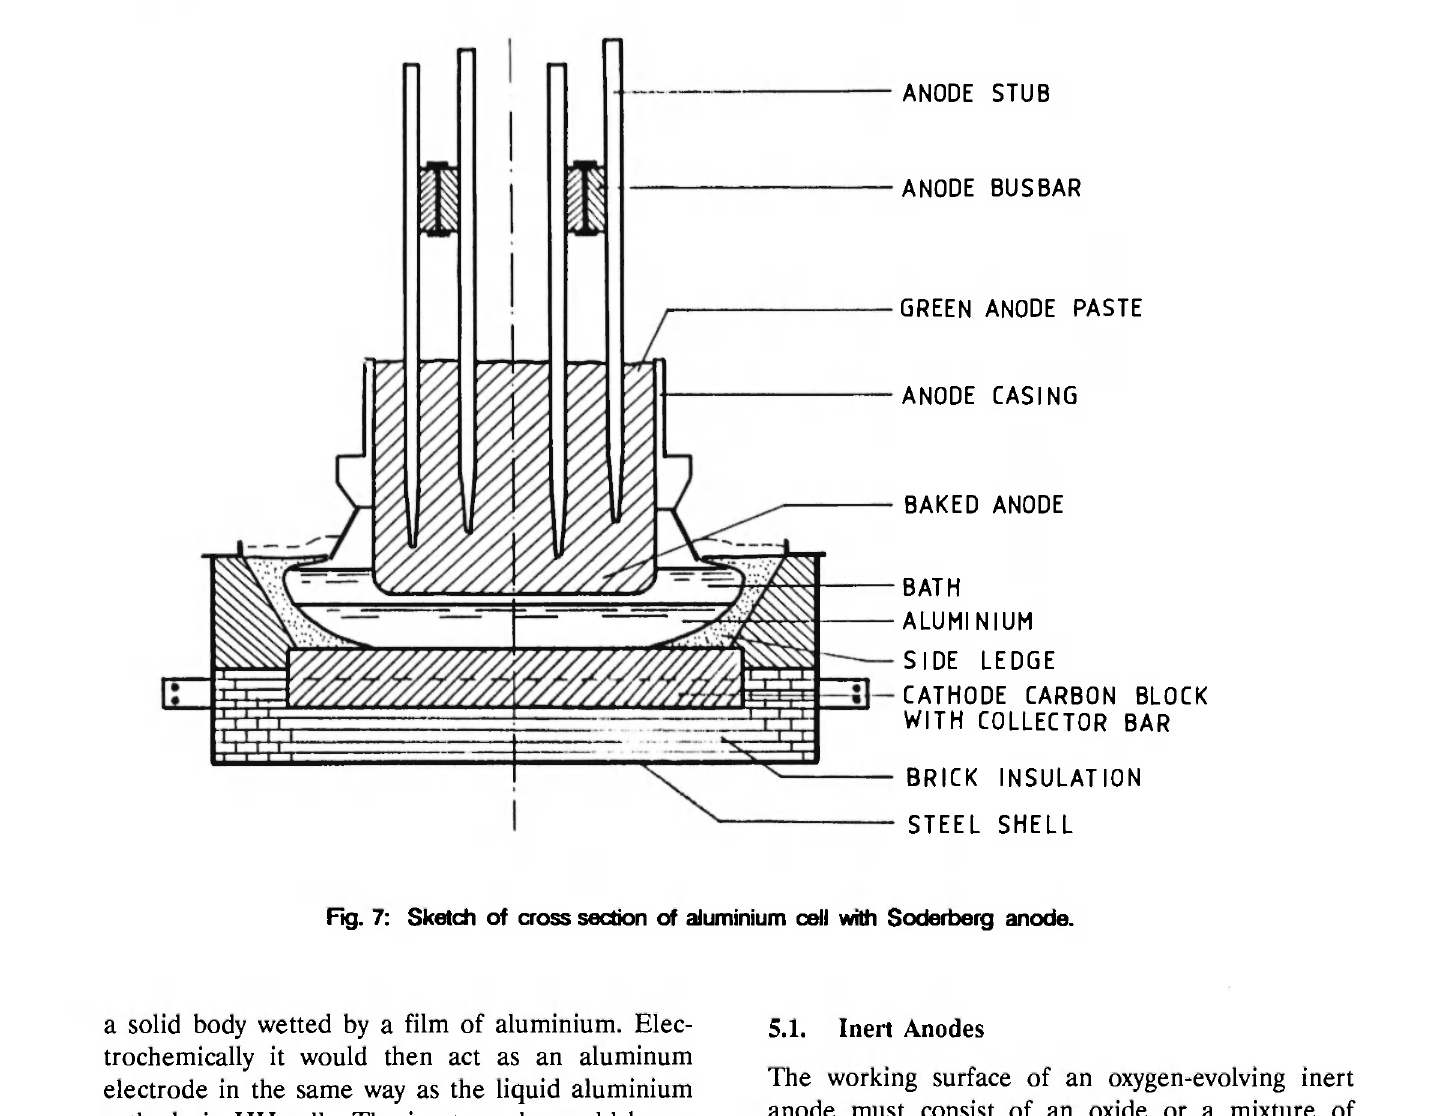
Fig. 7: Sketch of cross section of aluminium cell with Soderberg anode.